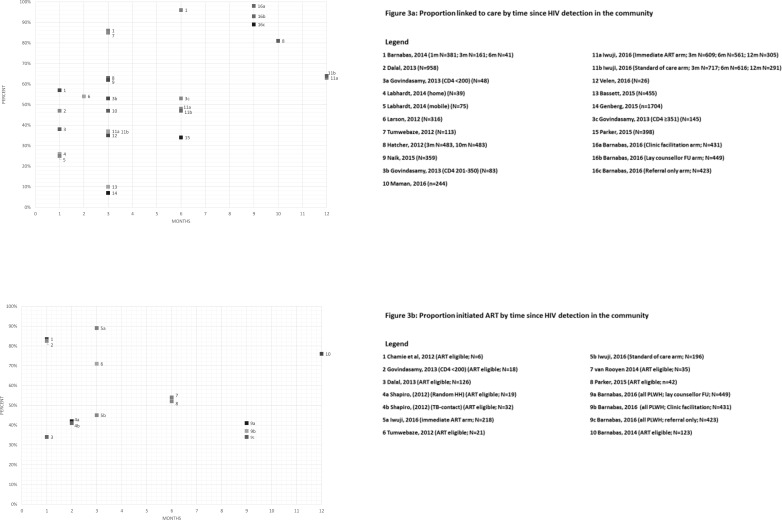
a-b: Time taken following HIV detection at HTS for individuals
to LTC (a);to initiate ART (b)